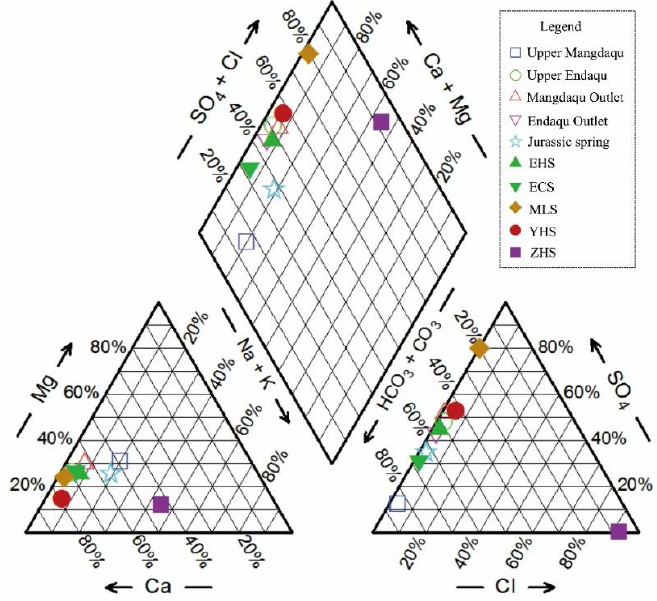
Figure 3. Piper three-line diagram of water samples in the study area.